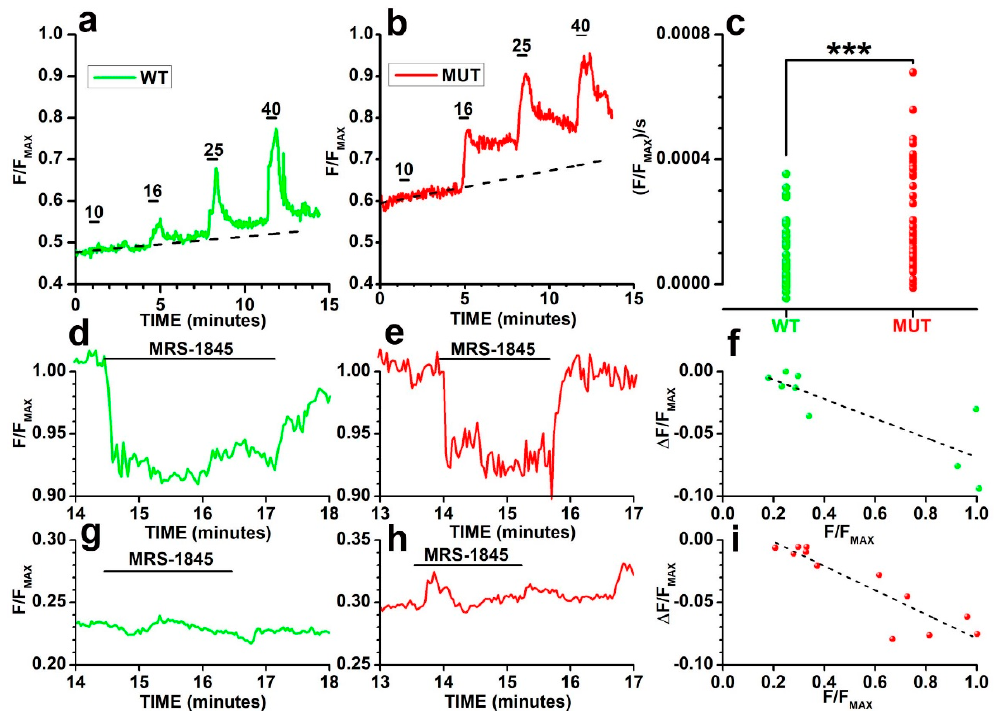
Figure 6. ( a , b ) Spontaneous and KCl-evoked changes in fluorescence in a WT ( a ) (green) and in ( b ) MUT (red) rod. VGCC were activated by the 30 s-long application (thick bars above records) of saline with increasing KCl concentrations (10, 16, 25, and 40 mM). Dashed lines plot the best fitting straight lines to sloping baselines. ( c ) Circles plot the distributions of baseline slopes ( ∆ F/F MAX /s/) for 39 WT and 49 MUT rods. A two-tailed t-test indicates a significant difference (t = − 4.02532 with 86 df: p = 1.22088 × 10 − 4 ) between mean ∆ F/F MAX /s of WT (8.90 × 10 − 5 ± 1.58 × 10 − 5 ) and MUT rods (20.68 × 10 − 5 ± 2.29 × 10 − 5 ). ( d , e ) Changes in normalized fluorescence (F/F MAX ) in response to the application of 15 µ M MRS-1845 (black bars above records) in WT ( d ) (green) and MUT ( e ) (red) rods having high F/F MAX before drug application. ( g , h ) Changes in normalized fluorescence (F/F MAX ) in response to the application of 15 µ M MRS-1845 (black bars above records) in WT ( g ) (green) and MUT ( h ) (red) rods having either high F/F MAX before drug application. ( f , i ) Circles plot the decreases in normalized fluorescence ( ∆ F/F MAX ) induced by 15 µ M MRS-1845 as a function of F/F MAX values preceding the application of the blocker in 9 WT ( f ) and 12 MUT ( i ) rods. Filled circles plot the values for the representative rods shown in panels ( f , h ). Black lines plot the best fitting linear regression lines. The two-way ANCOVA indicates the mean ∆ F/F MAX does not differ significantly between WT and MUT rods (F = 0.03 with 1, 18 df: p = 0.864423). The slope of the regression line does not differ significantly (F = 0.64 with 1, 17 df: p = 0.434748) between WT and MUT